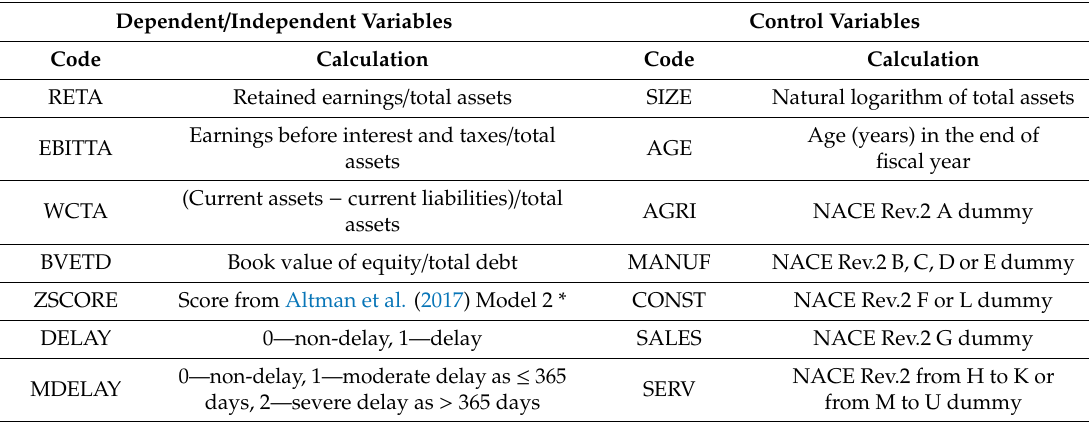
Table 1. Coding of the